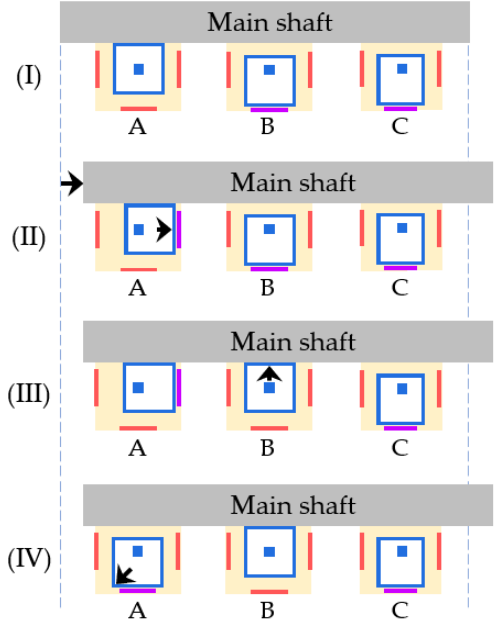
Figure 2. A diagram demonstrating the scheme of serial operations of the unit cells to actuate the main shaft. Each of the units A, B, and C represents a parallel-driven group of AUCs. In this illustration, a step displacement of the shaft (a full actuation cycle) requires three successive strokes by three AUC groups. The diagram reflects the operation of a single group, A, and how it overlaps with the other groups in a cycle. The small and large blue squares represent the anchor and moveable electrode in an AUC, respectively. The purple or red strips represent the electrically charged or grounded electrodes, respectively. It starts after the main shaft has been made mobile by disengaging it from the stationary holder (yellow structure in Figure 1). Simultaneously, the shaft will be clutched by group A, whose teeth are aligned to those of the shaft, whereas the other groups are already pulled away ( I ). Group A then actuates the shaft (side actuation; rightward arrows) until reaching the stroke limit ( II ). Afterwards, group B, which is now aligned to the shaft, returns to home position (upward arrow) and clutches the shaft ( III ). Lastly, group A disengages from the shaft (diagonal arrow) to allow group B to handle the shaft from this point onward ( IV ), then similarly hand it over to group C (not shown), and the cycle repeats.